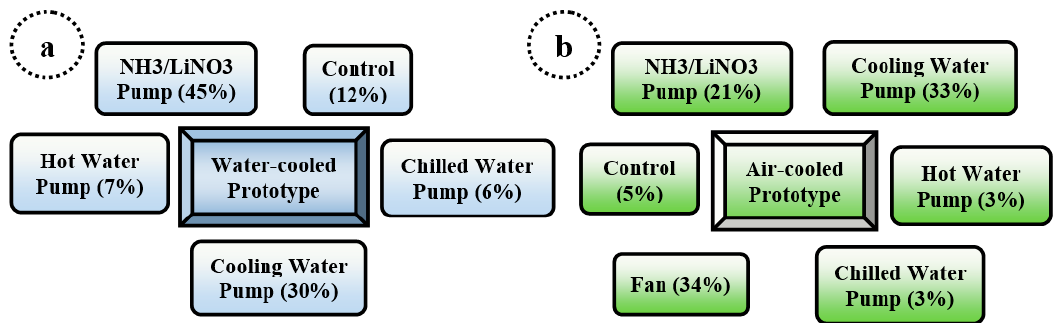
Figure 15. Distribution of the global electricity consumption of the two absorption chiller prototypes: ( a ) Water-Cooled Prototype ( b ) Air-Cooled Prototype.